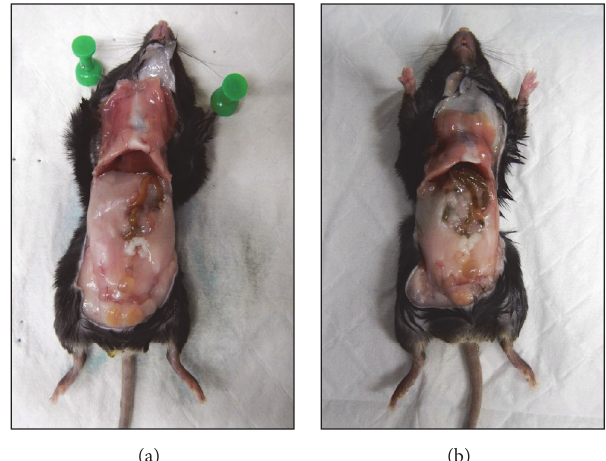
Figure 4: Neutralisation of ADAM19 reduces high fat diet induced obesity. Representative photographs of HFD-fed mice administered with either rabbit IgG (a) or ADAM19 neutralising antibody (b). Mice administered rabbit IgG possessed increased gonadal adipose tissue compared to mice administered ADAM19 neutralising